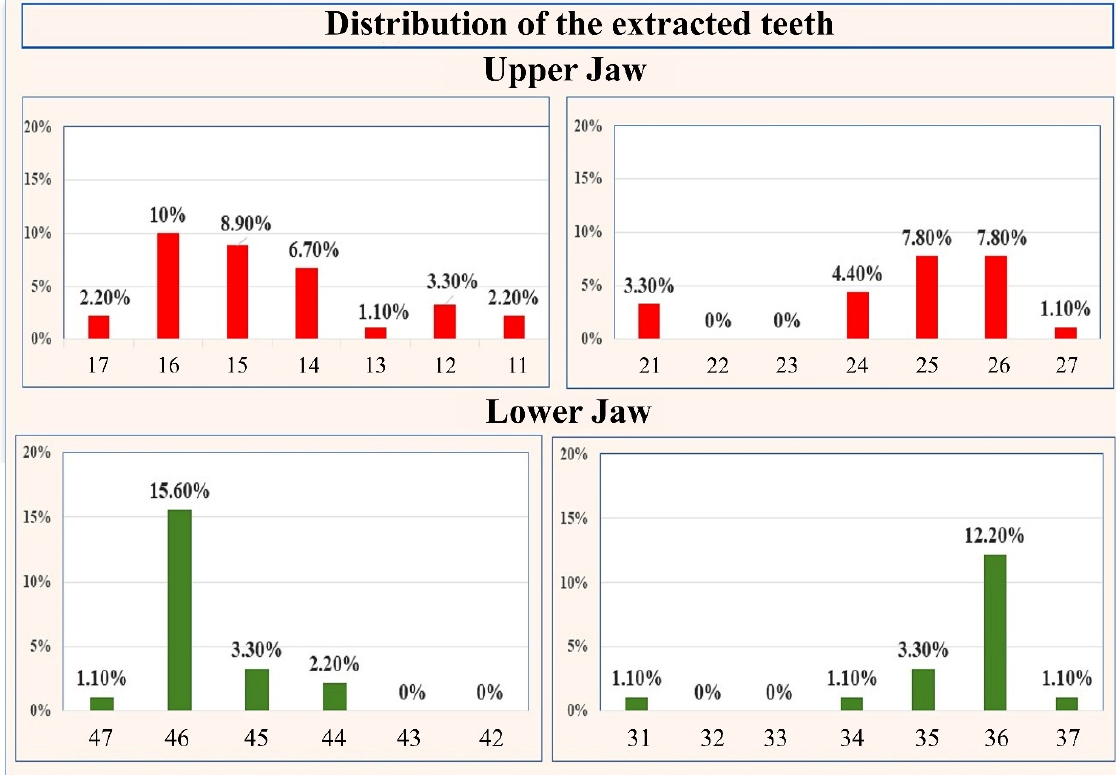
Figure 7 . Distribution of the extracted teeth. Figure 7. Distribution of the extracted